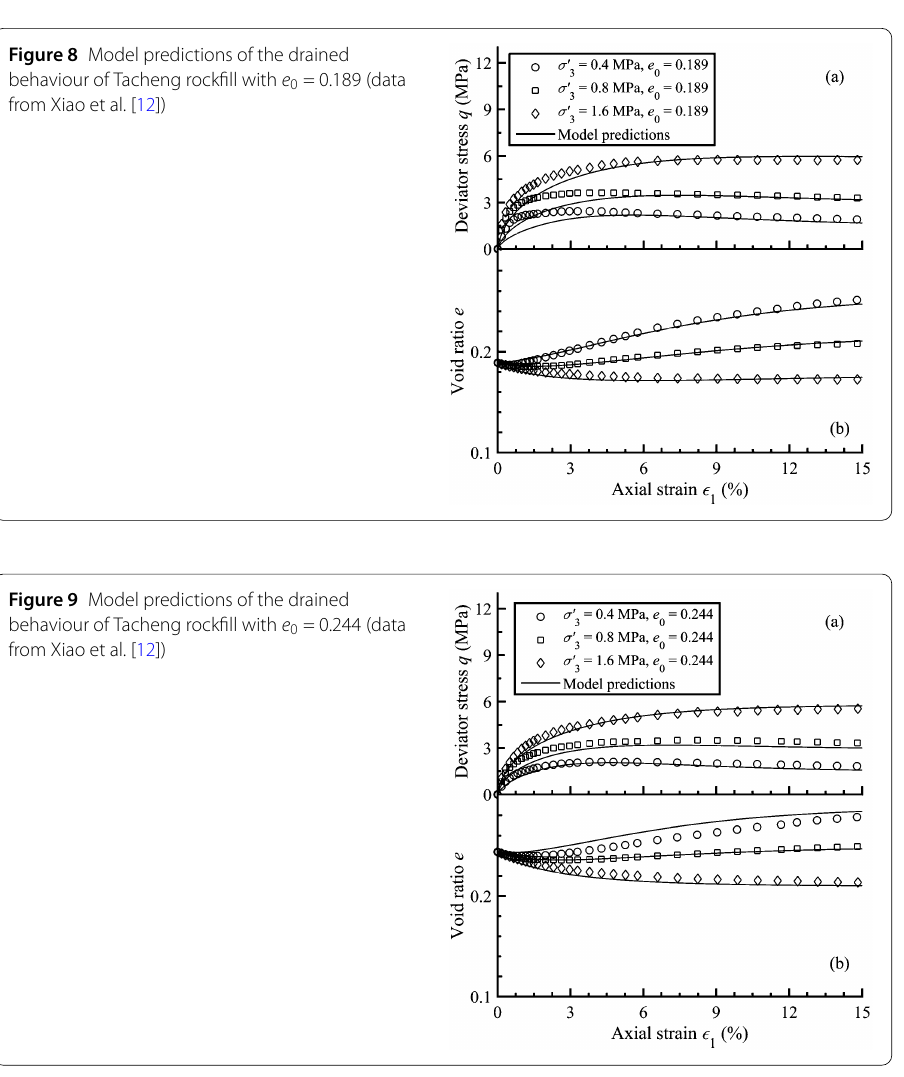
Figure 8 Model predictions of the drained behaviour of Tacheng rockfill with e 0 = 0.189 (data from Xiao et al. [12])